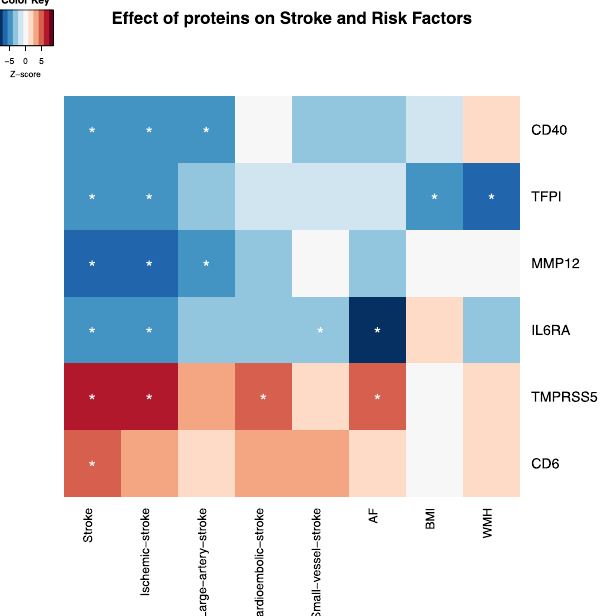
Fig.5|Effectsizes( Z -score)ofsixpotentialcausalproteinsonstrokeoutcomes and causal riskfactorsfor stroke. MRanalysesof the effectof proteins on stroke and stroke risk factors. Colours in each lattice of the heatmap represent the effect size ( Z -score), with genetically predicted increased protein level associated with a higher riskof outcomescoloured inbrownand lowerriskofoutcomescoloured in blue. The darker the colour the larger the effect size. *Indicates that the causal association is signi fi cant, which passed Bonferroni correction of P causalEstimate_IVW ≤ 0.05/308=1.61×10 − 4 and passed sensitivity tests with P ≥ 0.05 and Qstat P EggerIntercept ≥